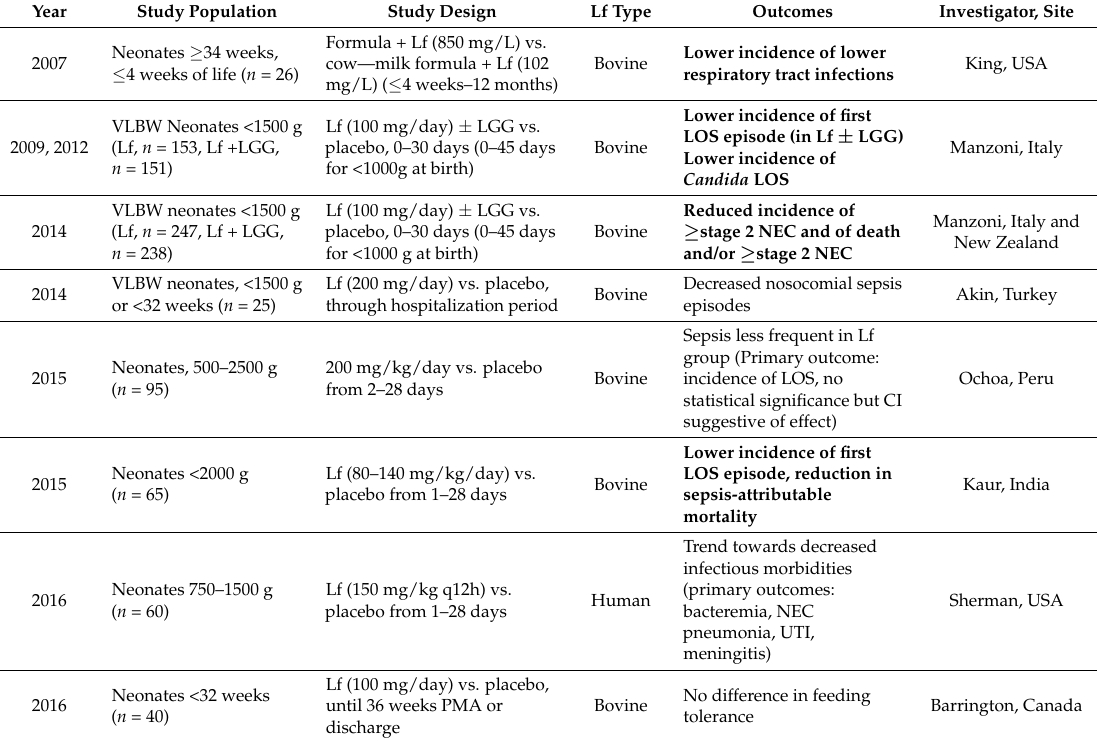
Table 1. Clinical Studies of Lactoferrin in Neonates. The n values denote the number of patients in the treatment groups. Significant study outcomes are in bold type. LOS, Late-onset